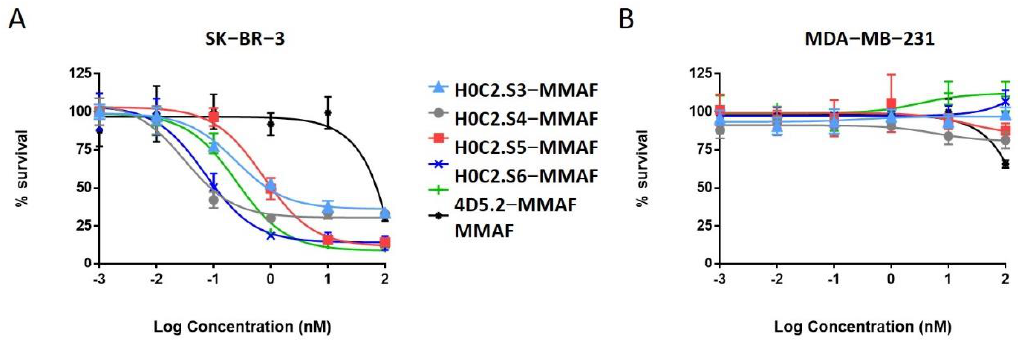
Figure 6. Cytotoxicity data for FDCs 4D5.2 − MMAF, H0C2.Sx − MMAF (x = 3 to 6) and unconjugated MMAF ( A ) on the HER2-overexpressing cell line SK − BR − 3 and ( B ) on the HER2 low expressing cell line MDA − MB − 231.